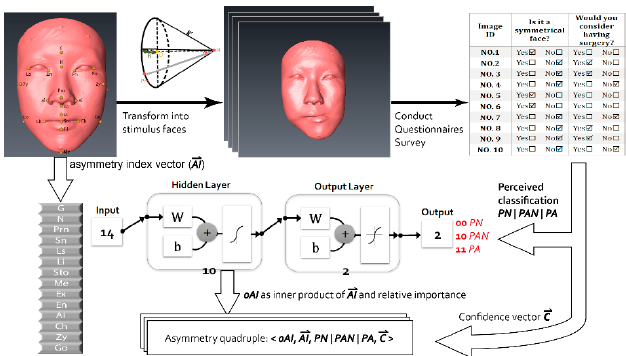
Figure 1. Procedure of composing the facial asymmetry quadruple.